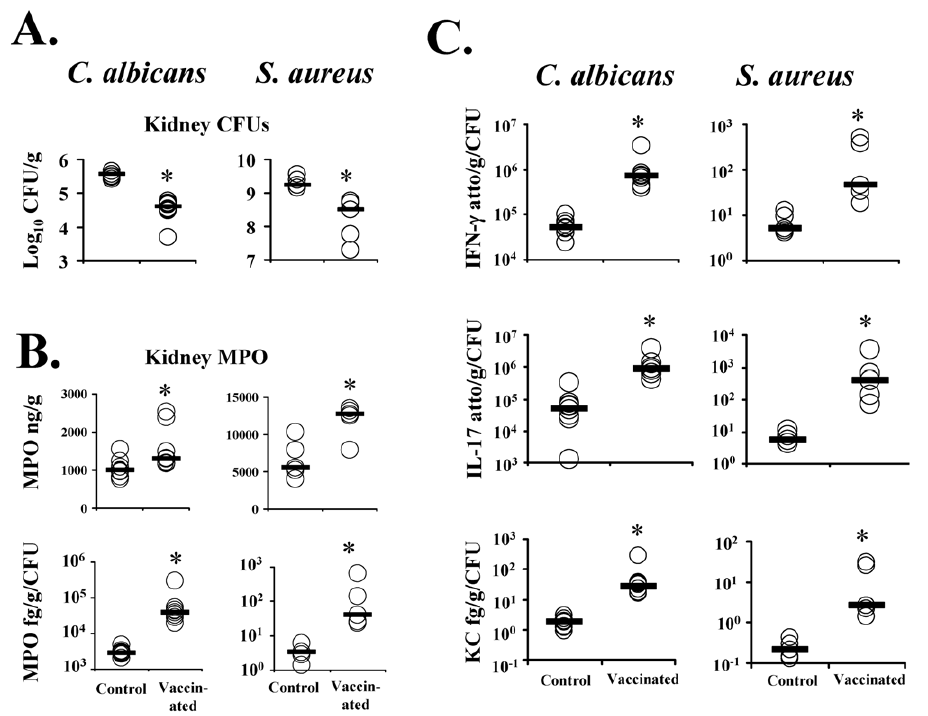
Figure 7. Vaccination reduced infectious burden and stimulated neutrophil influx by MPO and pro-inflammatory cytokine levels in kidneys. Balb/c mice, n=8 per group, were vaccinated with rAls3p-N plus Alhydrogel or Alhydrogel alone. Two weeks after the boost, mice were infected iv with C. albicans SC5314, 2 6 10 5 , or S. aureus LAC, 3 6 10 7 . Four days after infection, individually marked kidneys (primary target organ of infection for both models) were harvested, homogenized, and quantitatively cultured (A). MPO levels (B) and cytokine levels (C) in organ homogenates were measured by ELISA. MPO levels are shown both as raw values in ng/g of kidney tissue, and also normalized to burden of infection in each individually marked organ in fg/g tissue/CFU per organ. Cytokine levels are shown normalized to organ CFU burden. Median and interquartile ranges are shown. *p , 0.05 vs. Control by Mann Whitney U test.